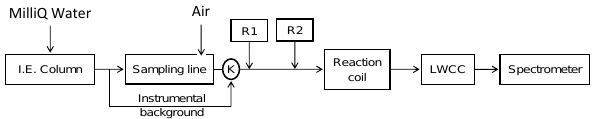
Fig. 1. Scheme of the instrument: R1 and R2 denote the phe- nol+nitroprusside and hypochlorite respectively. LWCC: Liquid Waveguide Capillary Cell. The instrumental background is taken by measuring clean water, by-passing the sampling line. The valve K is where the standard solutions were